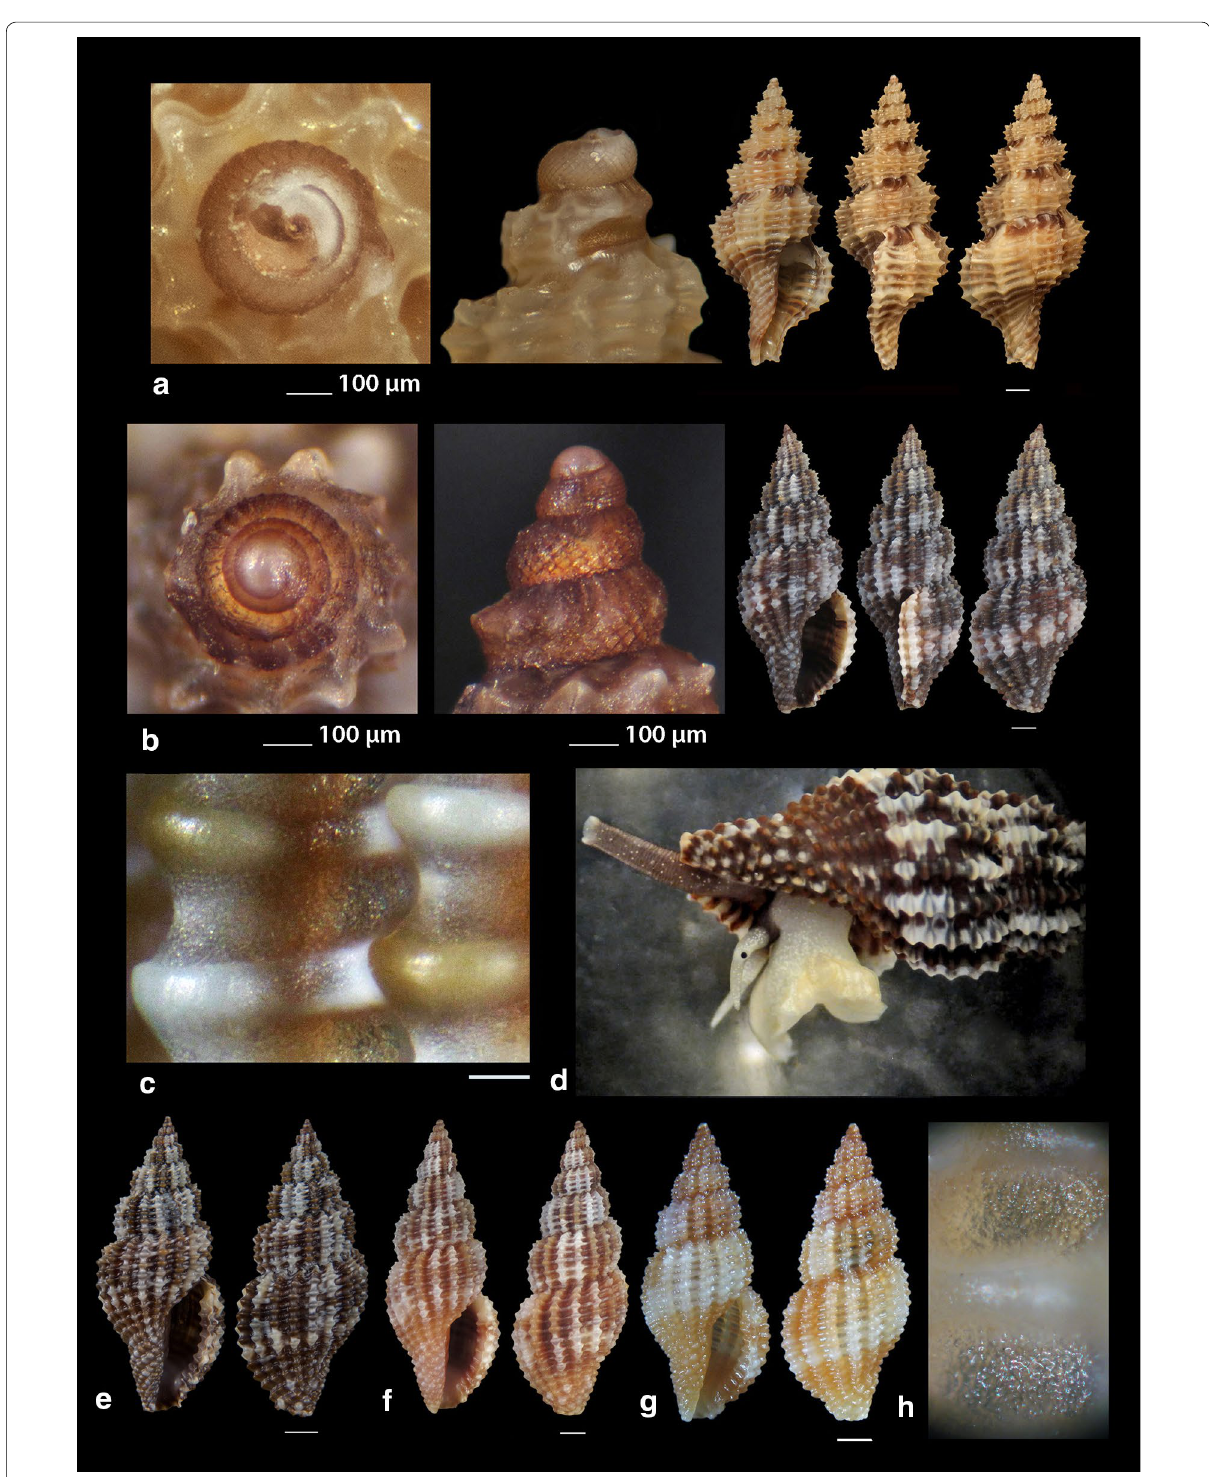
Fig. 7 a Raphitoma cordieri , b – h . Raphitoma densa , c surface of specimen ( b ), d live specimen, h surface of specimen ( g ). Barr otherwise